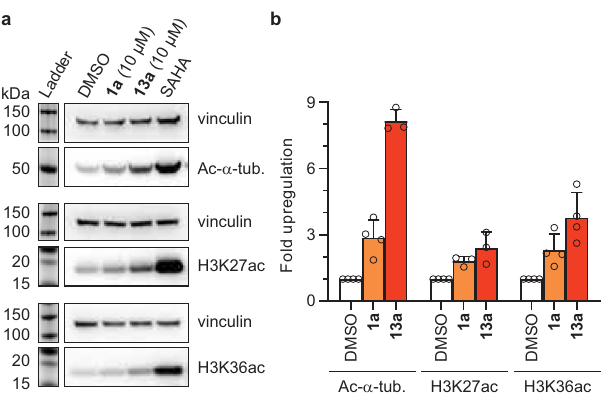
Fig. 7 Inhibition of HDACs in cultured cells. a Sample Western blots on tubulin acetylation (Ac- α -tubulin) and histone acetylation (H3K27, H3K36) upon 5 h treatment with peptides 1a and 13a at 10 µ M concentration, with SAHA as positive control (Ac- α -tubulin: 1 µ M; H3K27ac, H3K36ac: 5 µ M). See Supplementary Fig. 14 for full blots of all replicates. b Quanti fi cation of acetylation, normalized to vinculin loading control, and relative to DMSO (data represent mean ± SD, n = 4 biologically independent samples). Source data are provided as a Source Data fi